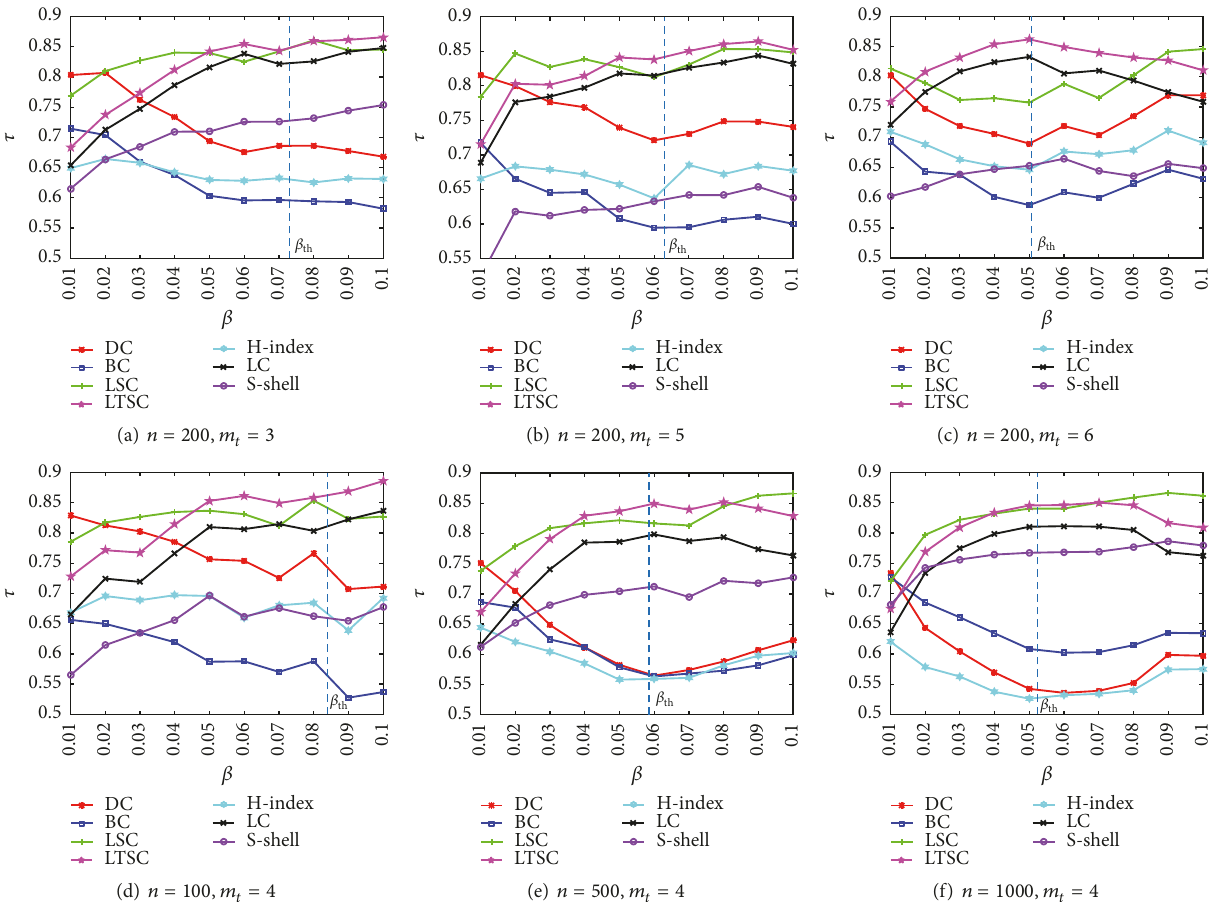
Figure 7: Kendall’s 𝜏 coefficients of the ranks obtained by one of seven measures and the SIR model in the BA networks. The seven measurements are DC, BC, H-index, S-shell, LC, LSC, and LTSC.